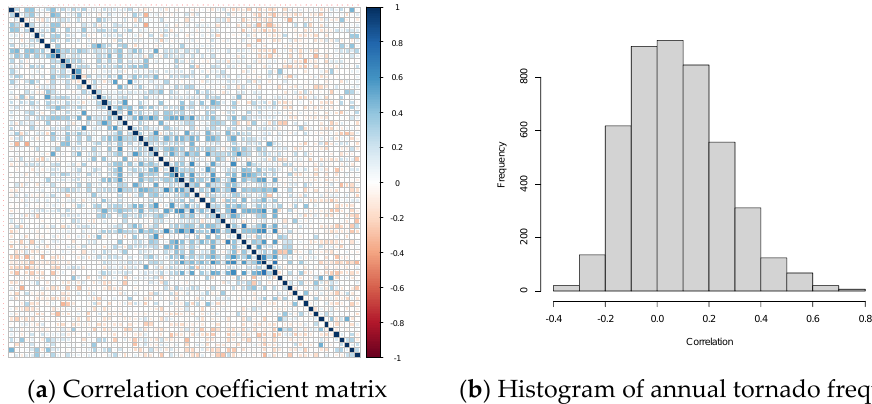
Figure 1. Grid division of tornadoes in the United States from 1967 to 2016.